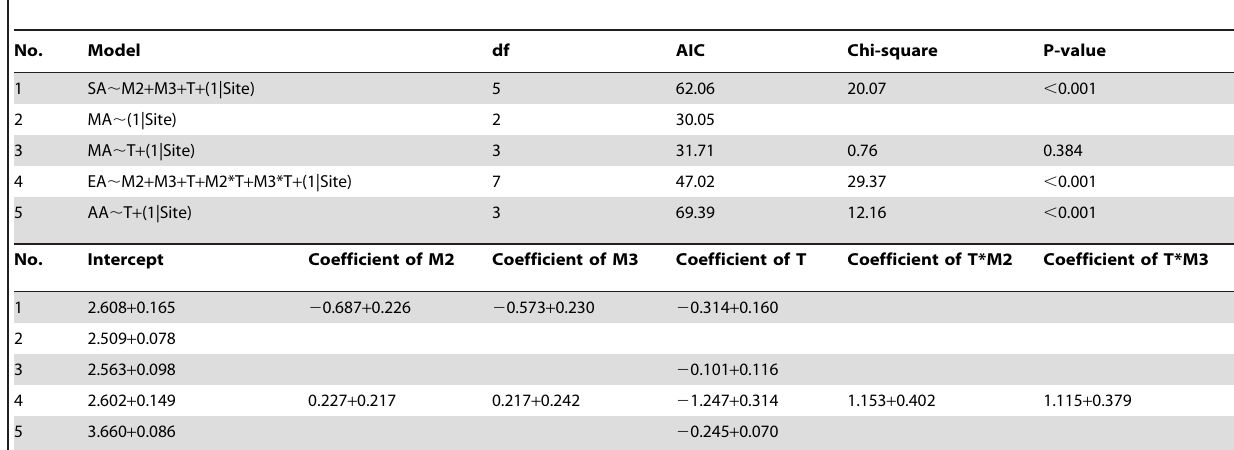
Table 2. Results from the GLMM analyses showing the best models for taxon richness of sessile epibenthic animals (SA), mobile epibenthic animals (MA), endobenthic animals (EA) and all animals (AA) with fixed effects for census methods (M2 and M3), tsunami (T) and their interactions.